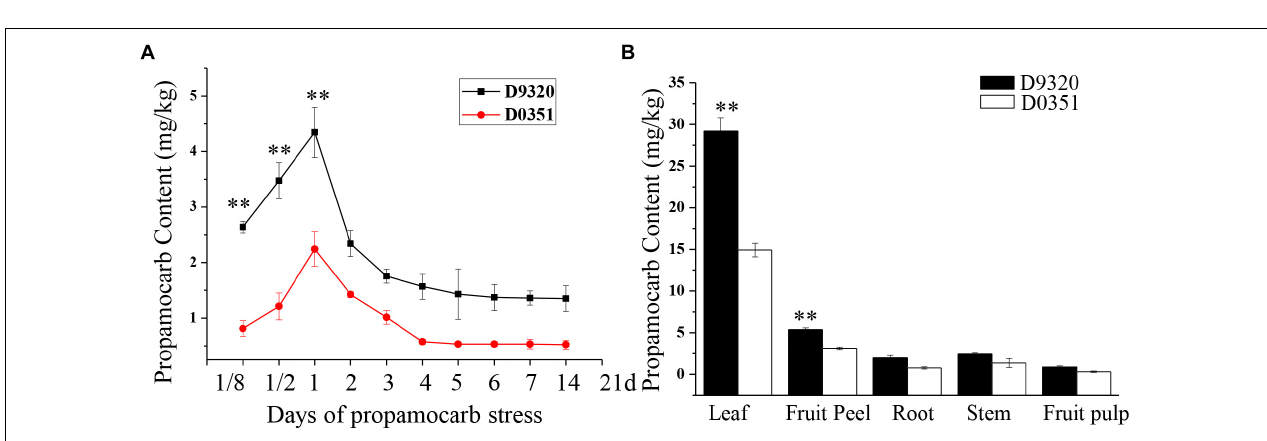
FIGURE 1 | Effects of propamocarb application in cucumbers. (A) Phenotype of cucumber leaves following 400, 800, and 1,200 ppm propamocarb applied to “D0351” and “D9320” genotype plants at 2 days after application. (B) MDA content in “D0351” and “D9320” genotype plants at 2 days. Data are the means of three replicates with SEs, and different letters indicate a significant difference ( p < 0.05 by Tukey’s test).